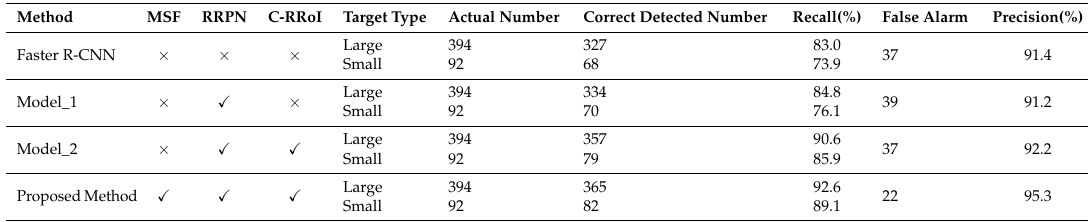
Table 1. Results of model analysis on our own dataset. MSF means multi-scale features, RRPN respresents rotation region proposal network, C-RRoI indicates pooling of contextual rotation RoI. “ (cid:88) ” means adopted while “ × ” means not. If one approach is not adopted, that part of structure is employed according to Faster R-CNN [19].